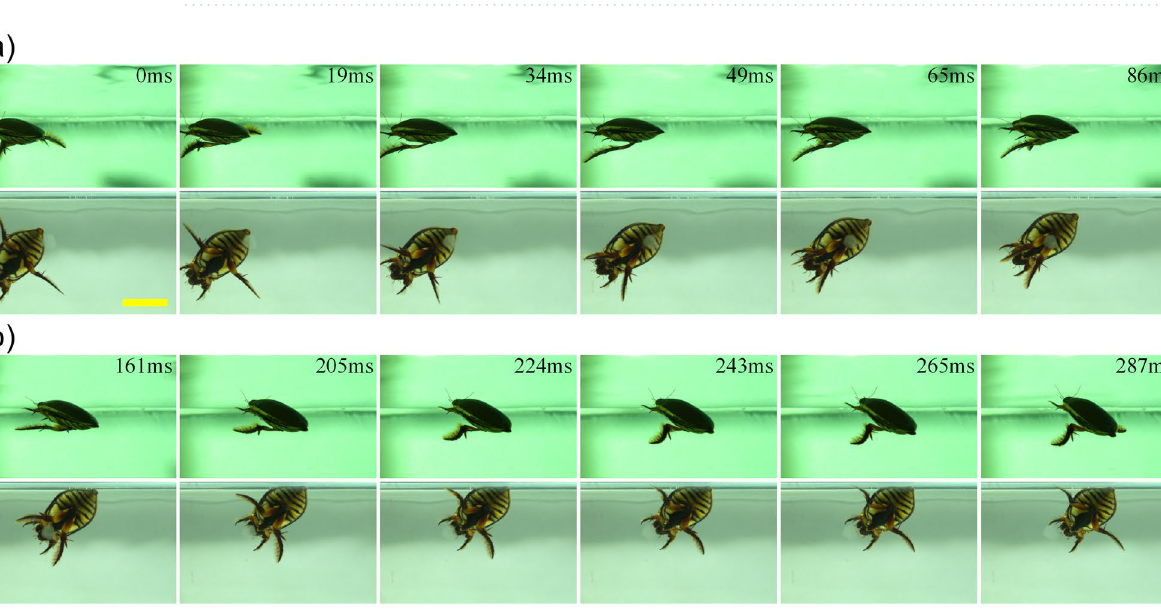
Figure 3. Time sequence diagram of a diving beetle for one retreating cycle: (a) the power stroke, which accounts for about 30% of the entire motion cycle; (b) the recovery stroke, the scale bar = 20